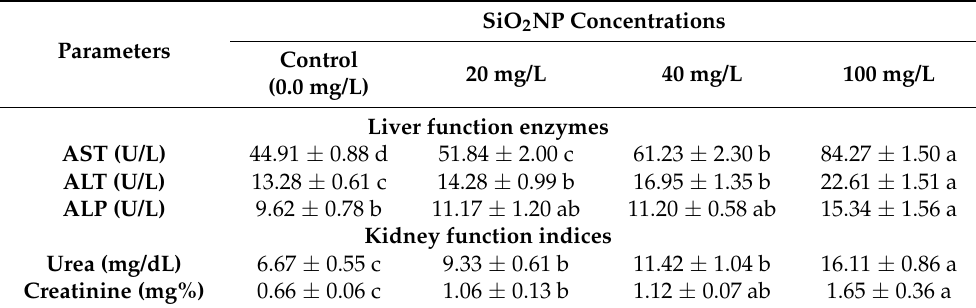
Table 2. Liver and kidney functions indices in the serum of Nile tilapia juveniles after exposure to different sub-lethal concentrations of SiO 2